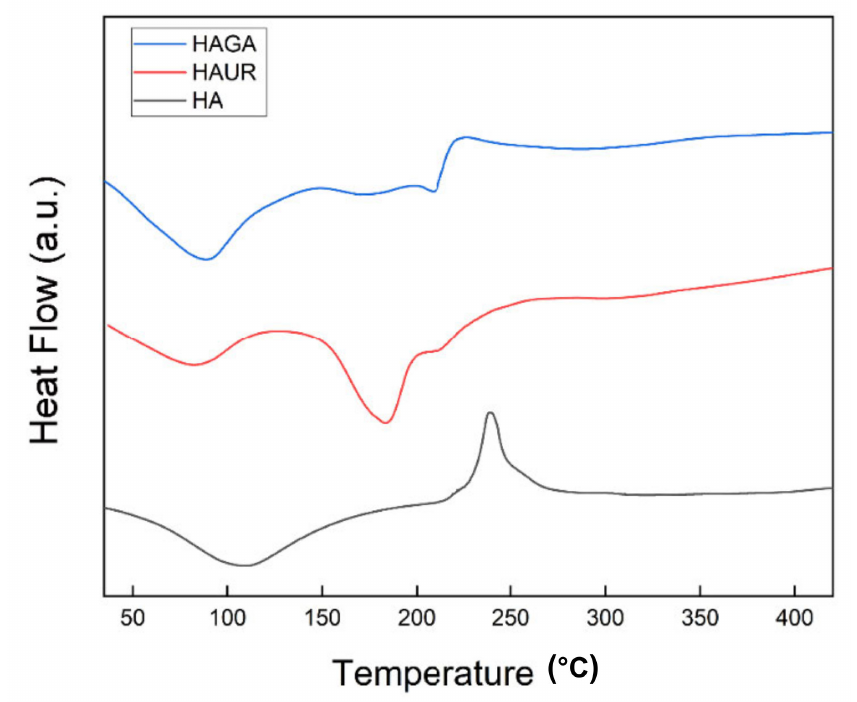
Figure 7. Differential scanning calorimetry (DSC) thermograms of microparticles formed from native (HA) and crosslinked (HAGA and HAUR)